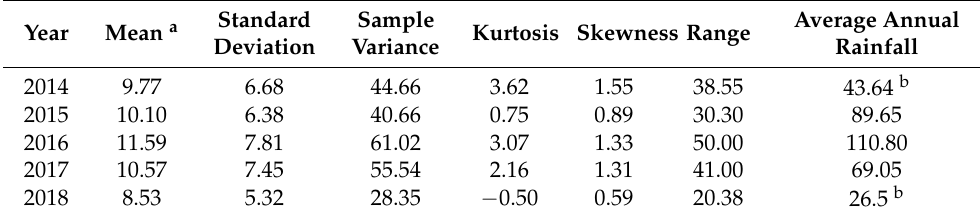
a The Mean is the average rainfall depth (mm) of annual rainfall events; b 2014 data spans from March–Dec, whereas for 2018 covers from January to